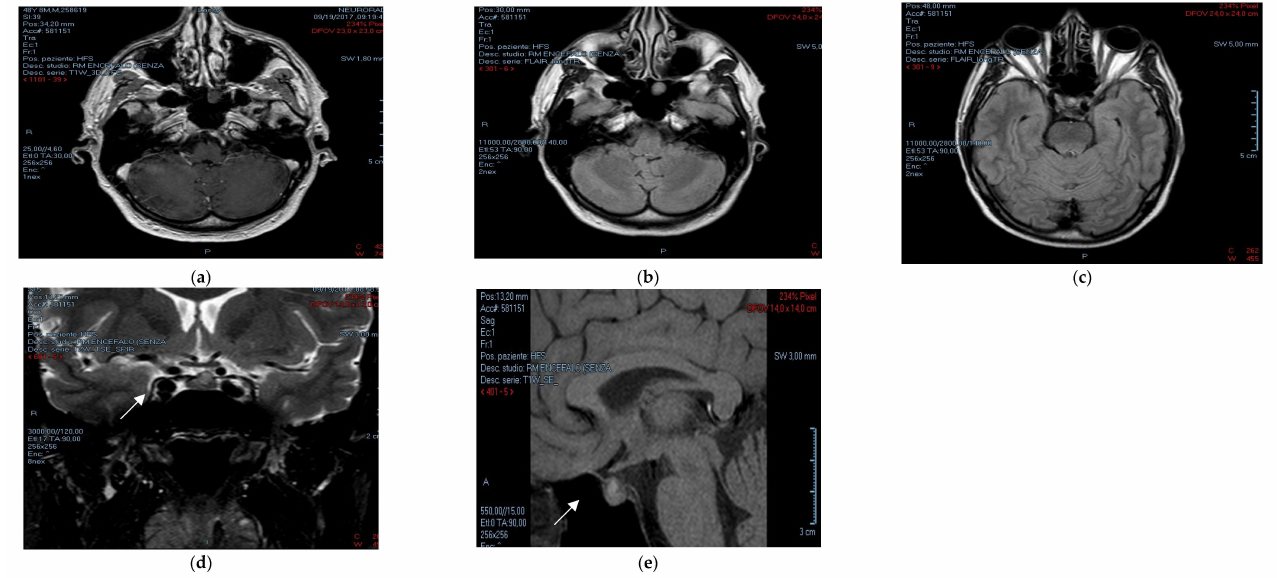
Figure 1. First MRI of pituitary gland performed at week 0, showing the presence of a pituitary lesion in different sections (white arrow). ( a – c ) show sequential scans of the encephalic region, while ( d , e ) show pituitary gland interested by